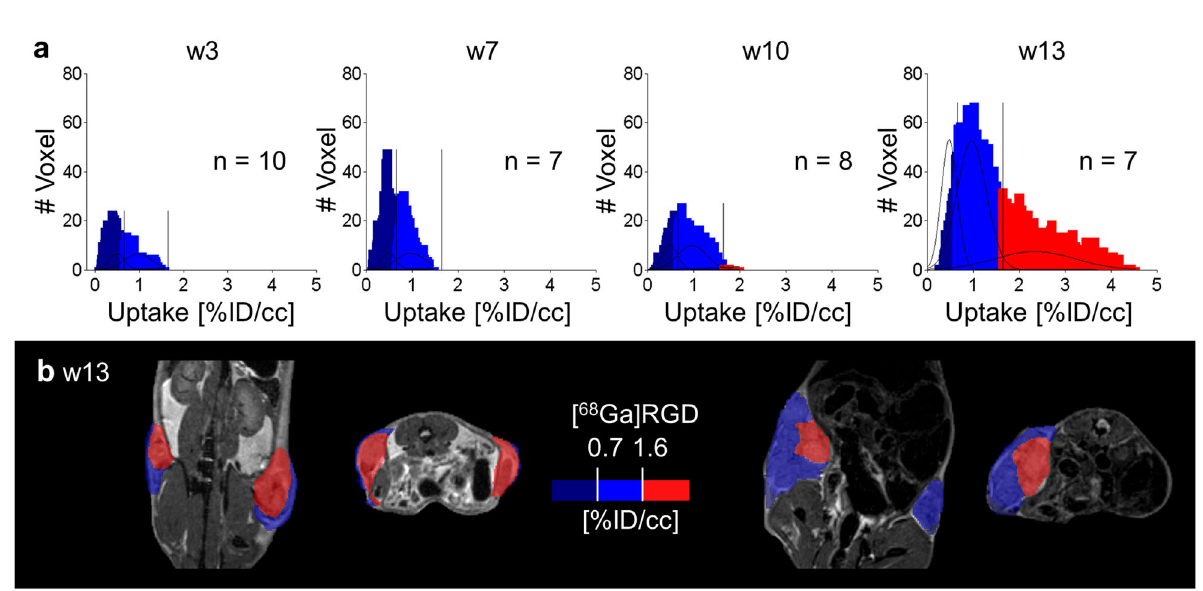
Fig. 5 GMM analysis of [ 68 Ga]RGD characterized IC regions. a The summed histogram of [ 68 Ga]RGD uptake of all tumors and all time points was fi tted and analyzed as described above for [ 18 F]FDG, resulting in a sum of 3 Gaussian distributions as the best model. The thresholds 0.7 and 1.6%ID/cc were applied to the histograms of the single time points. b Representative PET/MR images revealed the highest uptake population (red, > 1.6%ID/cc) in only large